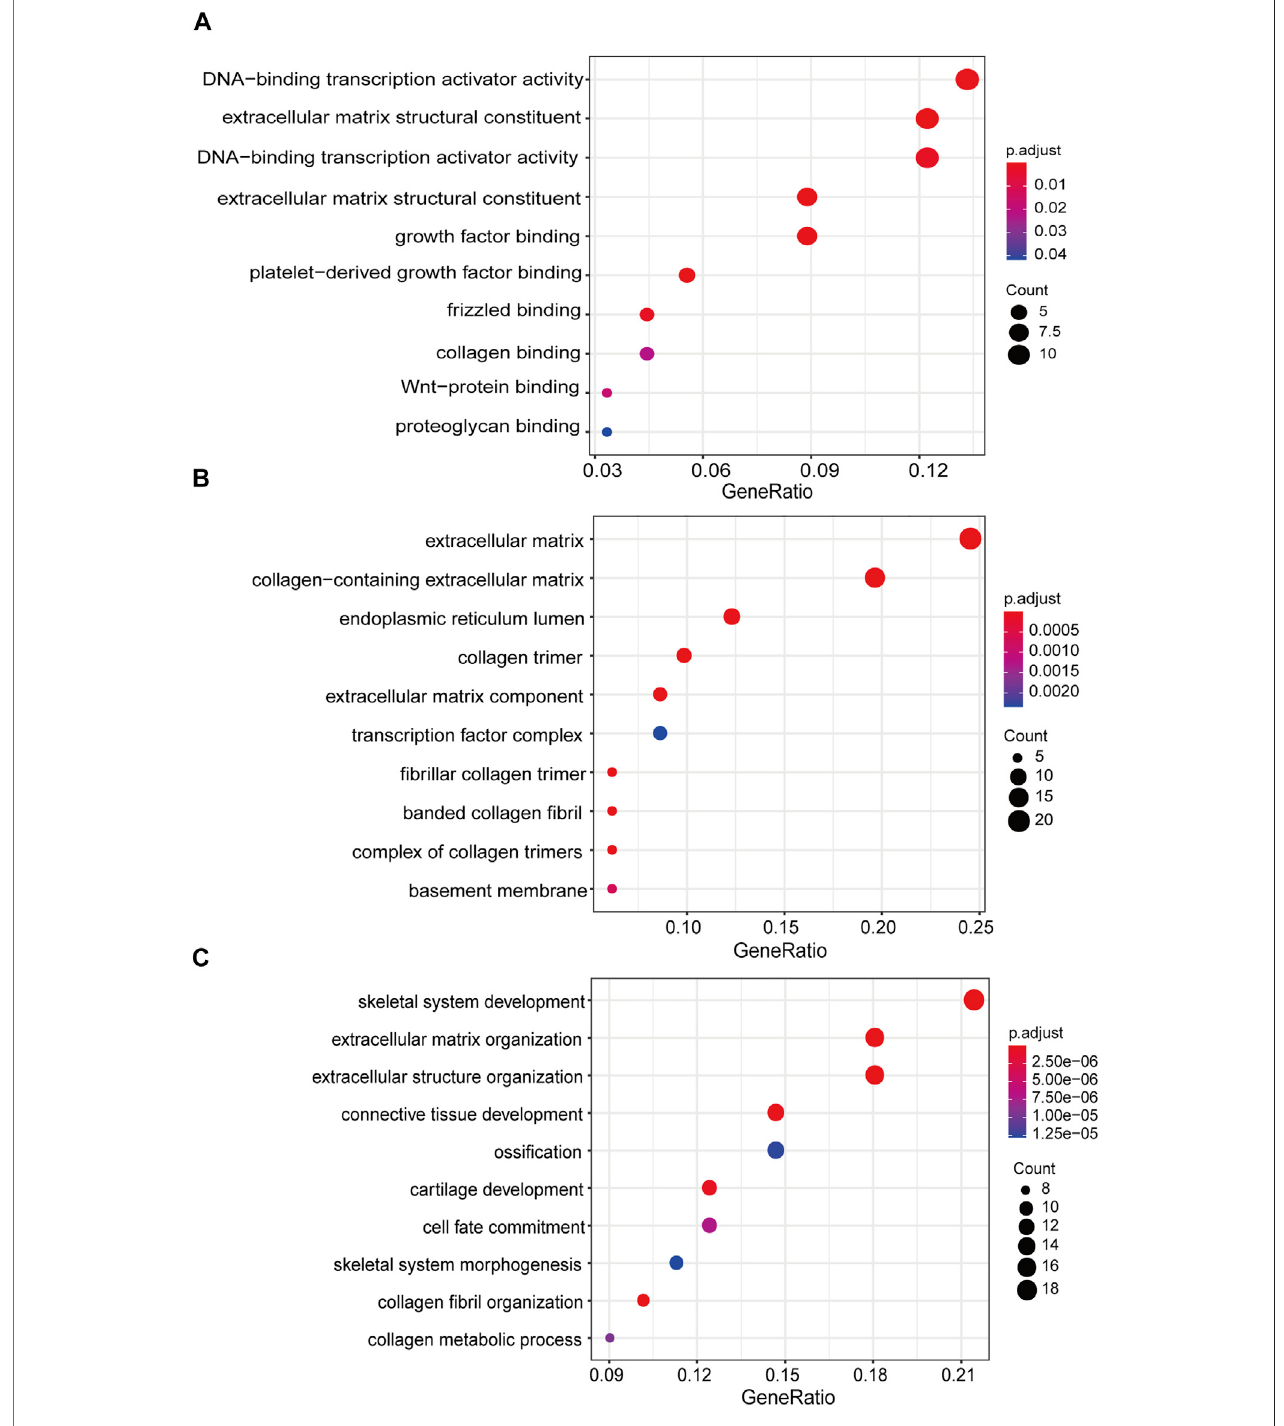
FIGURE 3 | GO analysis of the downregulated genes between LGG-P and LGG-R. (A) molecular function category; (B) cellular component category; (C) biological process category. The X -axis is the ratio of differentially expressed genes enriched in the corresponding pathway, and the Y -axis is the name of the